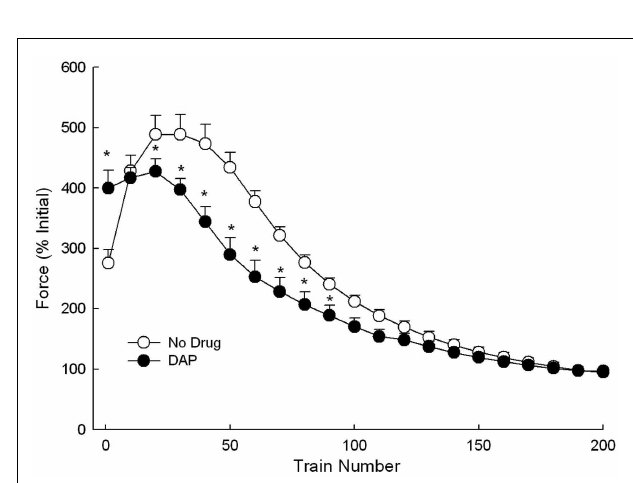
FIGURE 9 | Force during repeated 1.2mm 30Hz eccentric contractions at constant velocity of 6mm/s with and without DAP. Values are expressed as a percent of the initial pre-drug isometric twitch force.Values are means ±